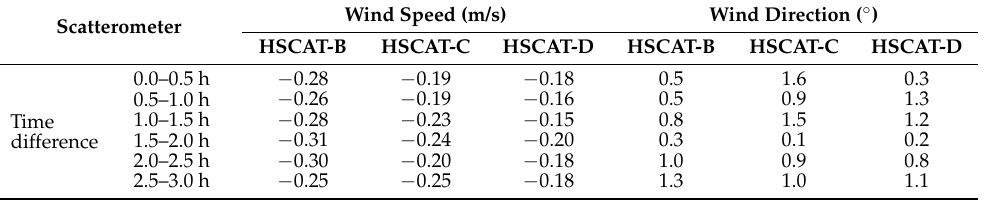
Table 2. Biases of the HSCATs winds with regards to. buoy measurements for different time windows.